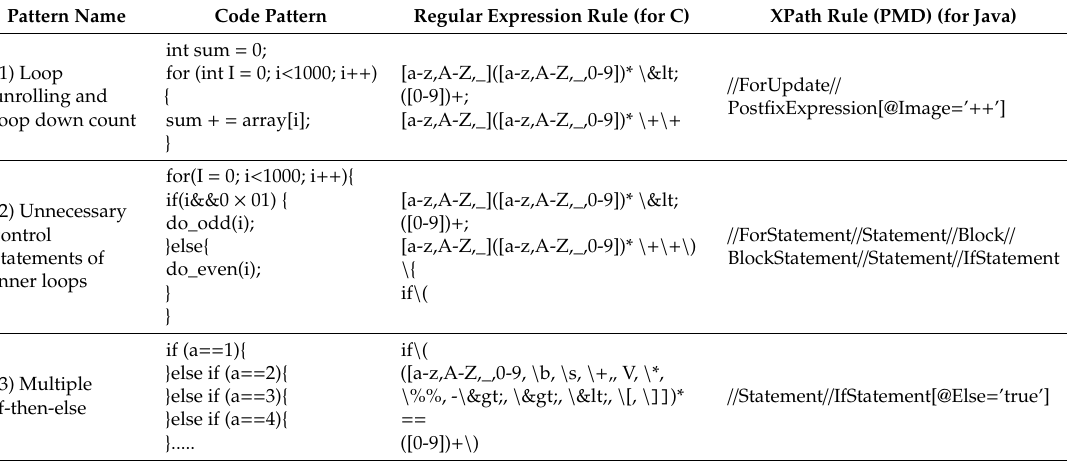
Table 4. Code patterns and rules of performance degradation. PMD, programming mistake